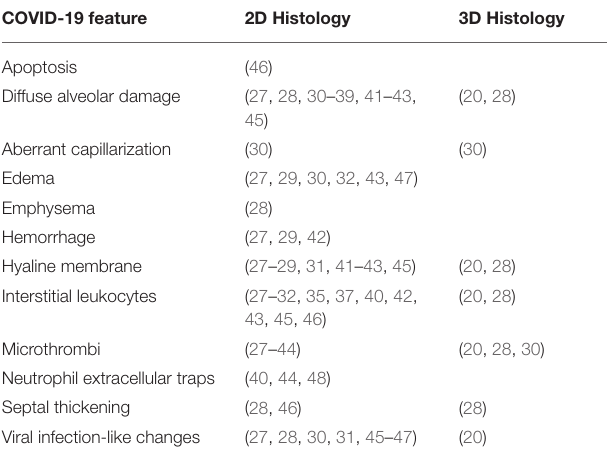
TABLE 1 | Pathological features of COVID-19